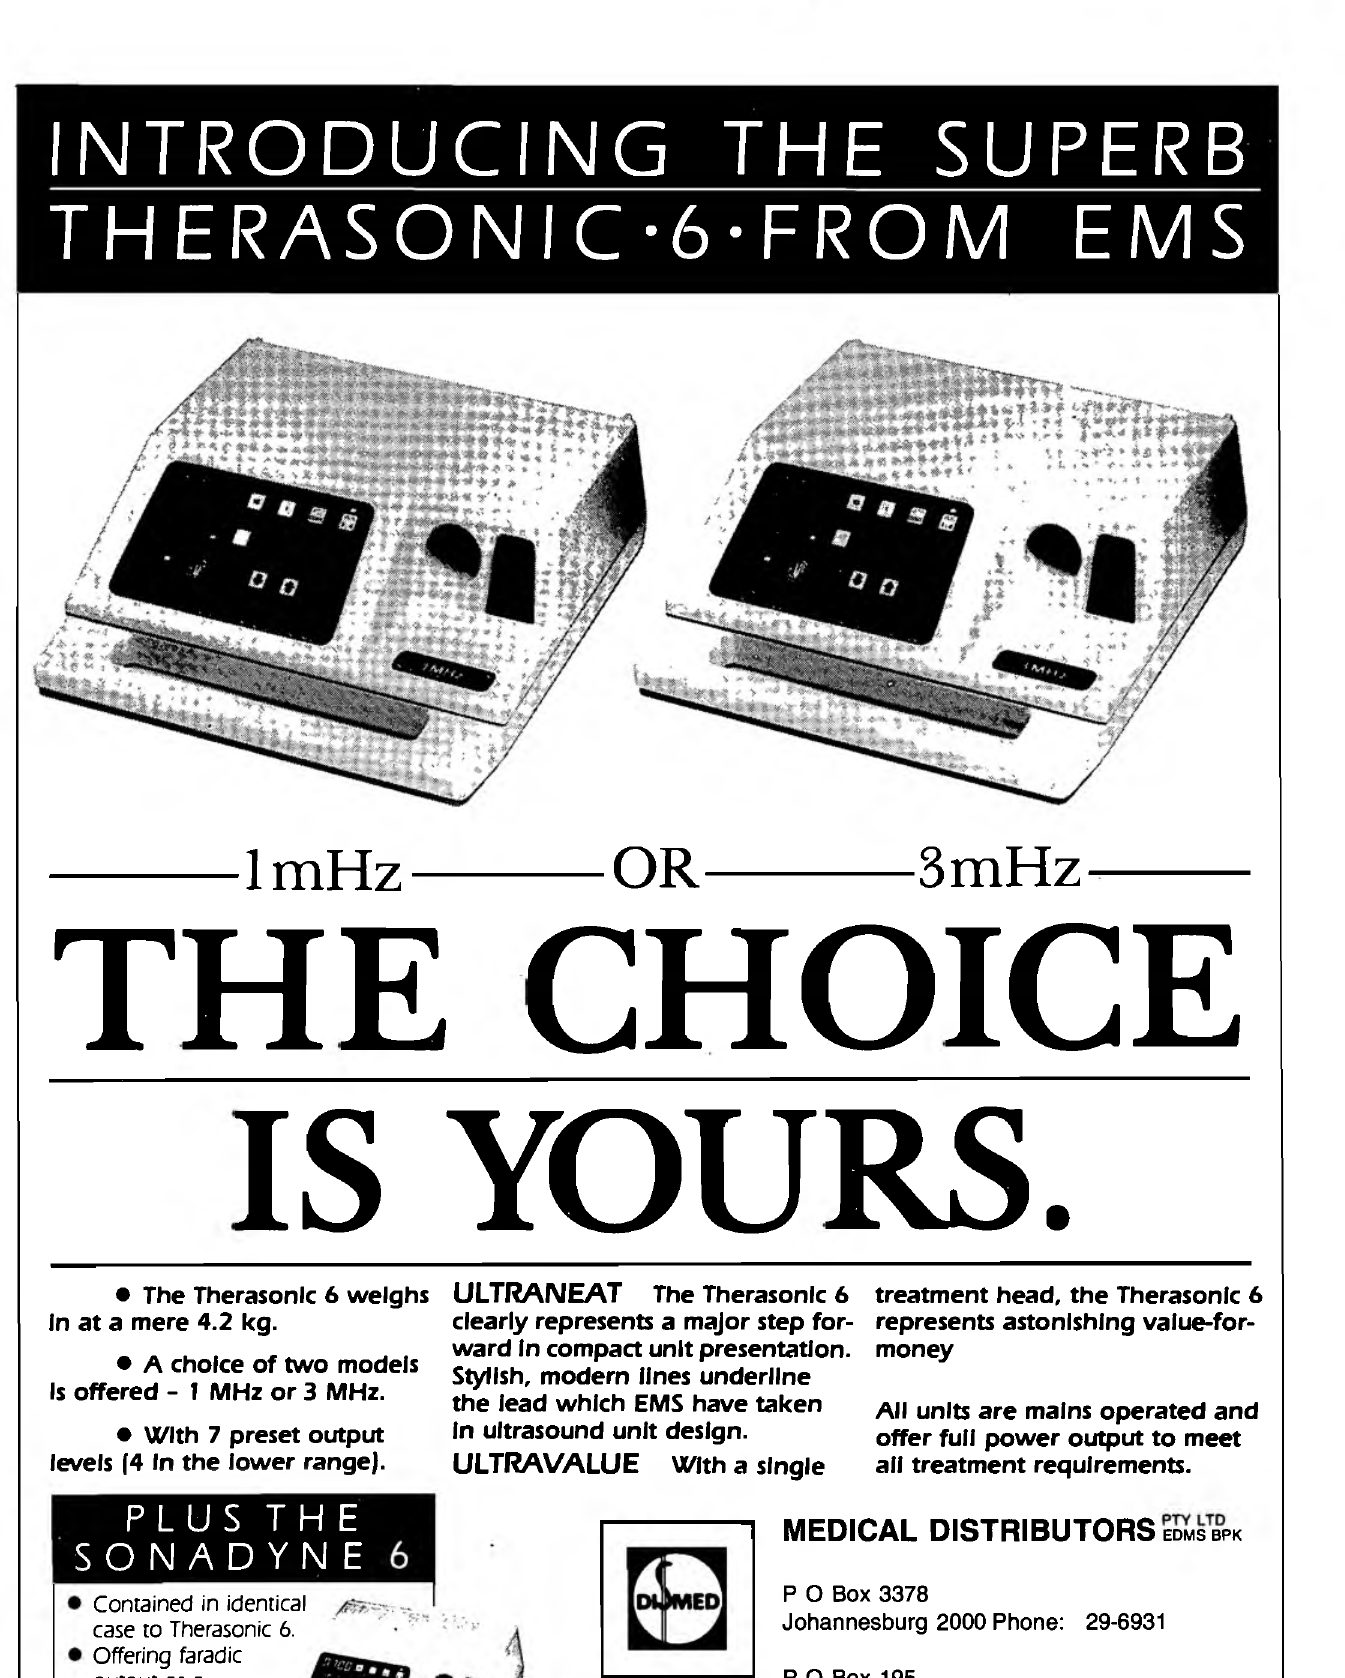
treatment head, the Therasonlc 6 represents astonishing value-for- money All units are mains operated and offer full power output to meet all treatment